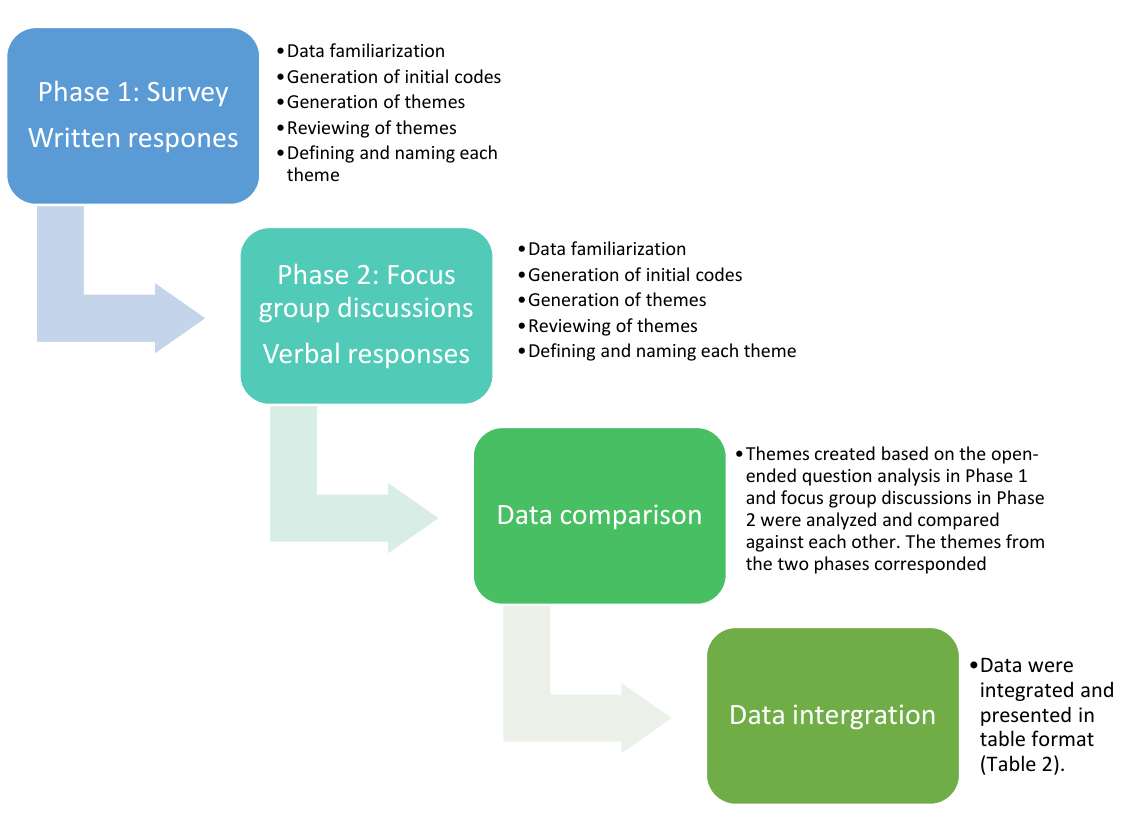
Figure 1. Process flow chart of thematic analysis.